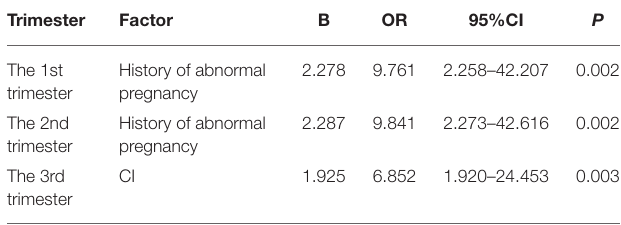
TABLE 4 | Multivariate regression analysis on the anxiety during pregnancy. TABLE 5 | Multivariate regression analysis on the depression during